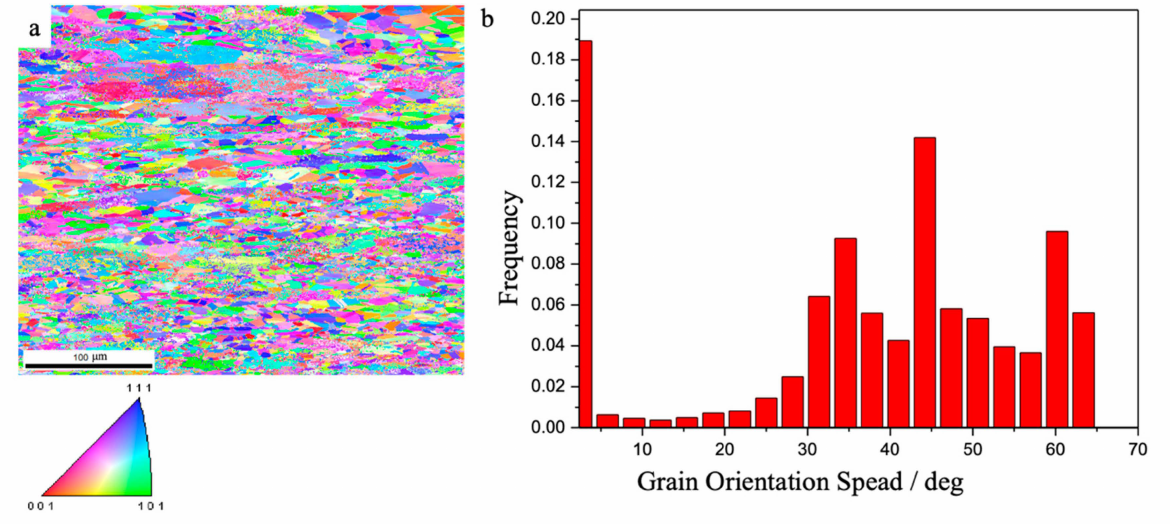
Figure 1. EBSD characterization of 7075 aluminum alloy: ( a ) grain orientation mapping and ( b ) the frequency of orientation